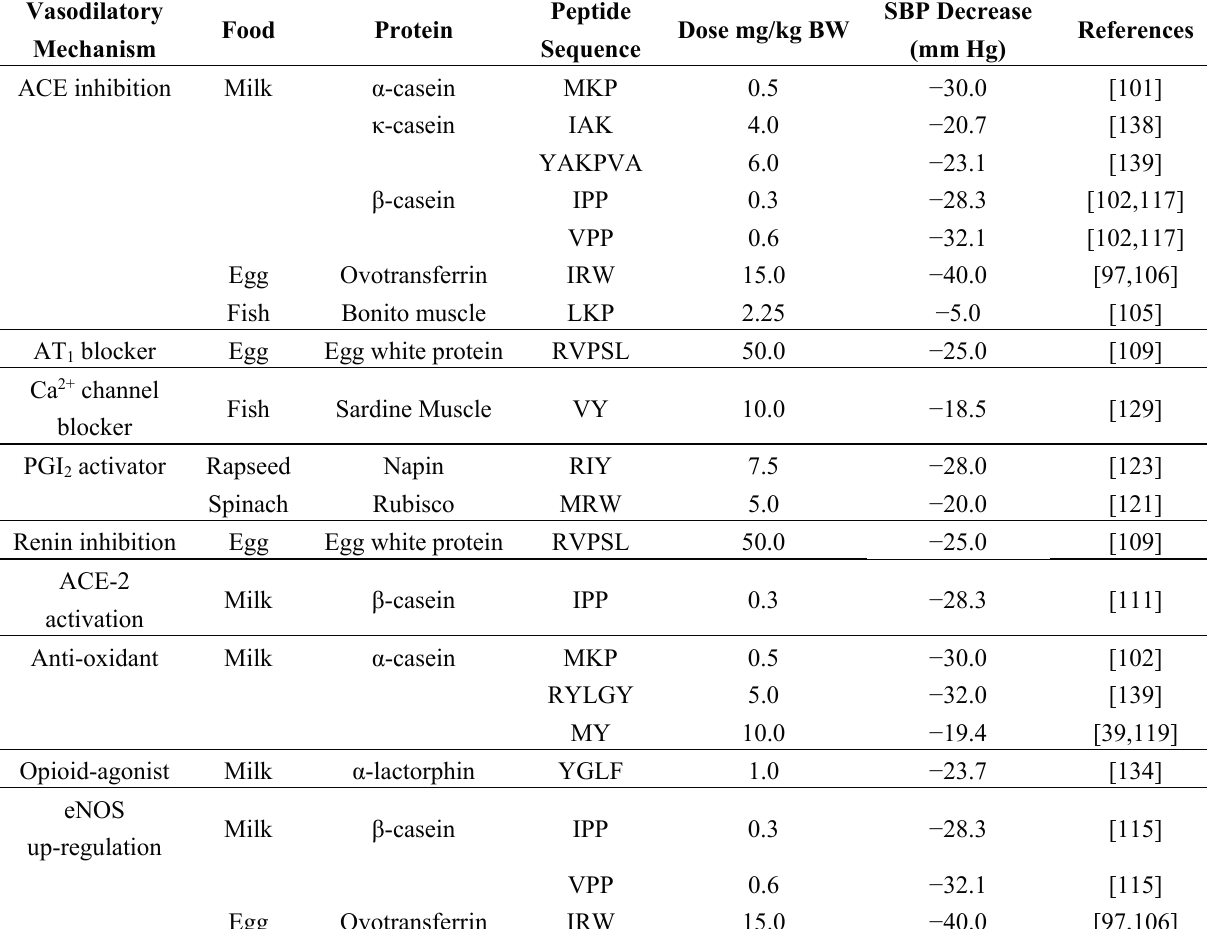
Table 1. Antihypertensive activity and vasodilatory mechanism of food derived bioactive peptides in spontaneously hypertensive